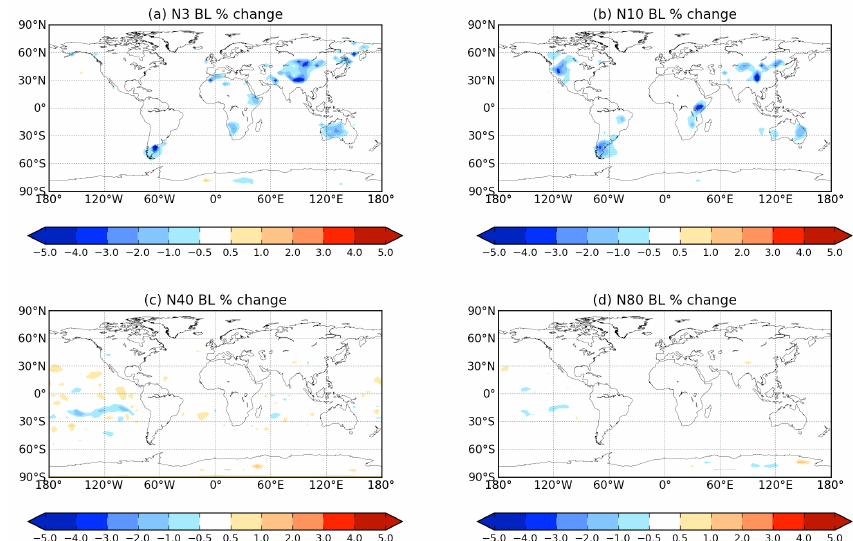
Fig. 6. Global annual-mean BL changes in (a) N3, (b) N10, (c) N40 and (d) N80 between SURF-XSOA and SURF-XSOA-K (red denotes higher concentrations in the SURF-XSOA-K simulation). There was a global BL decrease of 0.20%, 0.21%, 0.03% and 0.01% in N3, N10, N40 and N80 respectively when the linear sub-2.5 nm growth rate parameterization was included (Kuang et al., 2012).